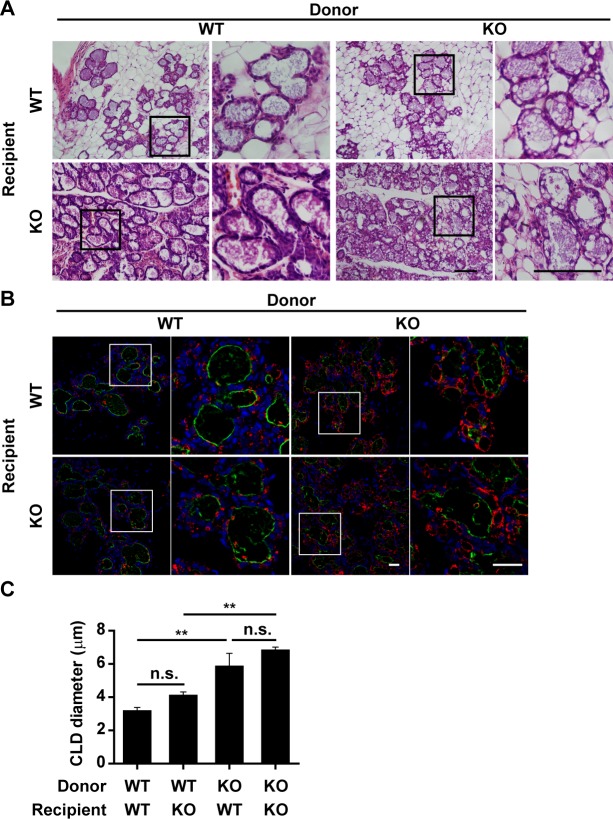
Impaired lipid secretion in Th-POK-deficient mammary glands is attributed mainly to intrinsic defects in the mammary epithelial cells.Wild-type or Th-POK-deficient mammary epithelial cells were implanted into clear fat pads of wild-type or Th-POK-deficient mice. Reconstituted mammary glands were harvested at lactation day 2. (A) Hematoxylin-and-eosin-stained sections of reconstituted mammary glands at lactation day 2. Scale bar: 100μm. (B) Sections of reconstituted mammary glands at lactation day 2 were stained with anti-Perilipin2 (red). The luminal surface of secretory alveoli was visualized with wheat germ agglutinin (green). Scale bars: 25μm. (C) Quantification of CLD size in transplanted mammary glands from WT and KO mice (N = 3, five fields/mice). Data are presented as mean ± SEM. Statistic analyses were performed with two-way Anova followed by Bonferroni's multiple comparison test. **P < 0.01. n.s.: not significant.